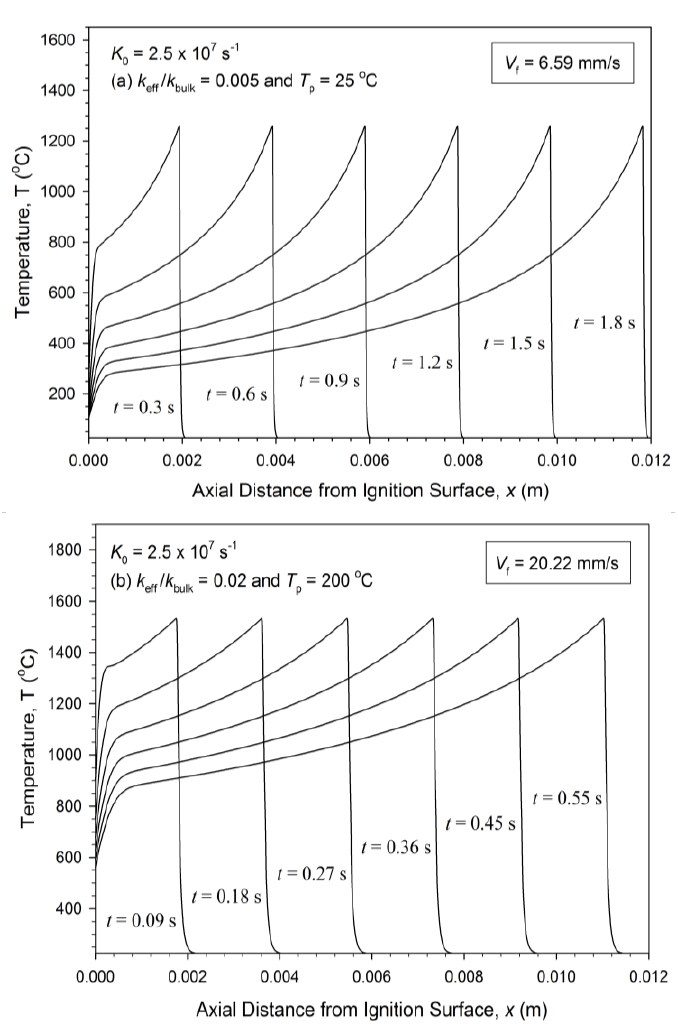
Figure 6. Calculated time histories of temperature profiles of Ta–Si powder compacts with ( a ) k eff / k bulk = 0.005 and T p = 25 °C and ( b ) k eff / k bulk = 0.02 and T p = 200